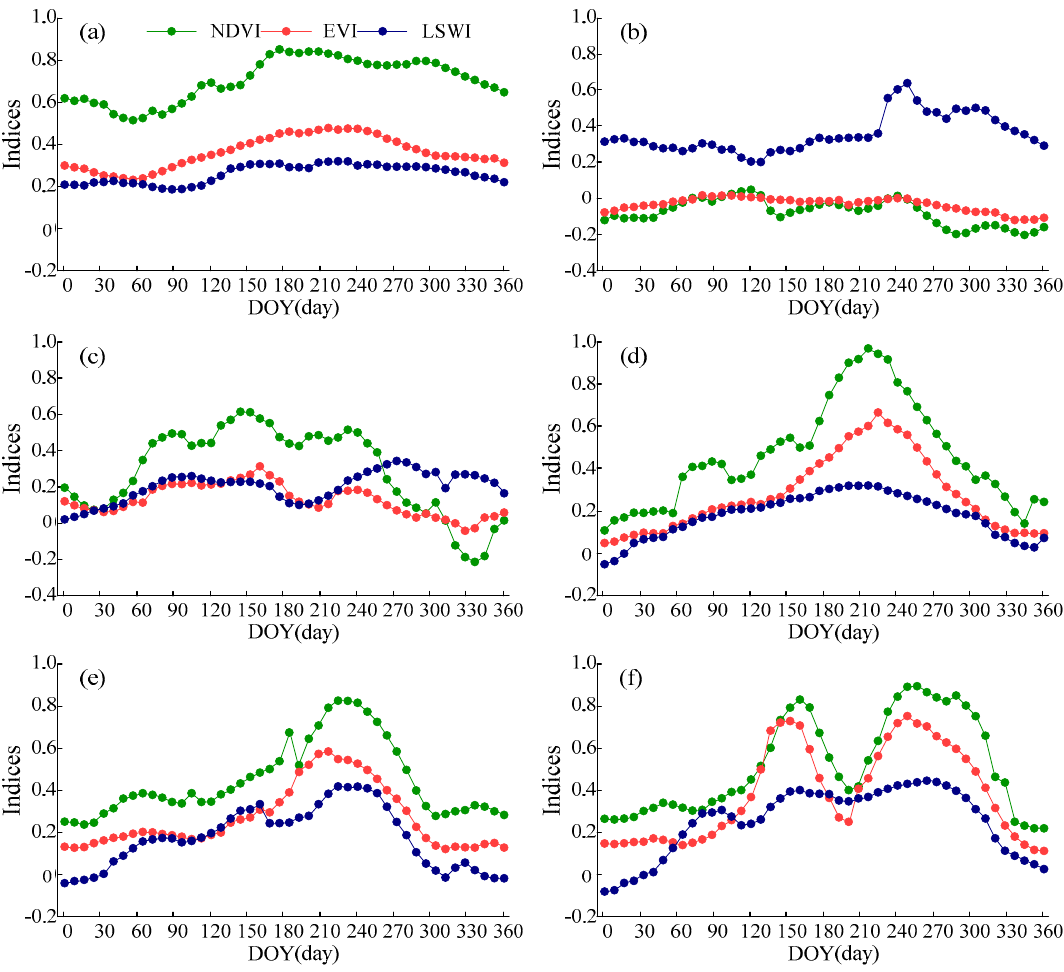
Figure 5. The seasonal dynamics of NDVI, EVI, and LSWI of major land-cover types from the MOD09A1 product in 2015. ( a ) A forest site (28.3291°N, 116.0492°E). ( b ) A water pool site (28.7244°N, 116.0859°E). ( c ) A natural wetland site (28.8878°N, 116.2718°E). ( d ) A lotus root site (28.9019°N, 116.2244°E). ( e ) A single-cropping rice site (28.4675°N, 116.0179°E). ( f ) A double-cropping rice site (28.6680°N, 116.2759°E). All sites were selected according to the field sampling sites and are representatives of major land-cover types.